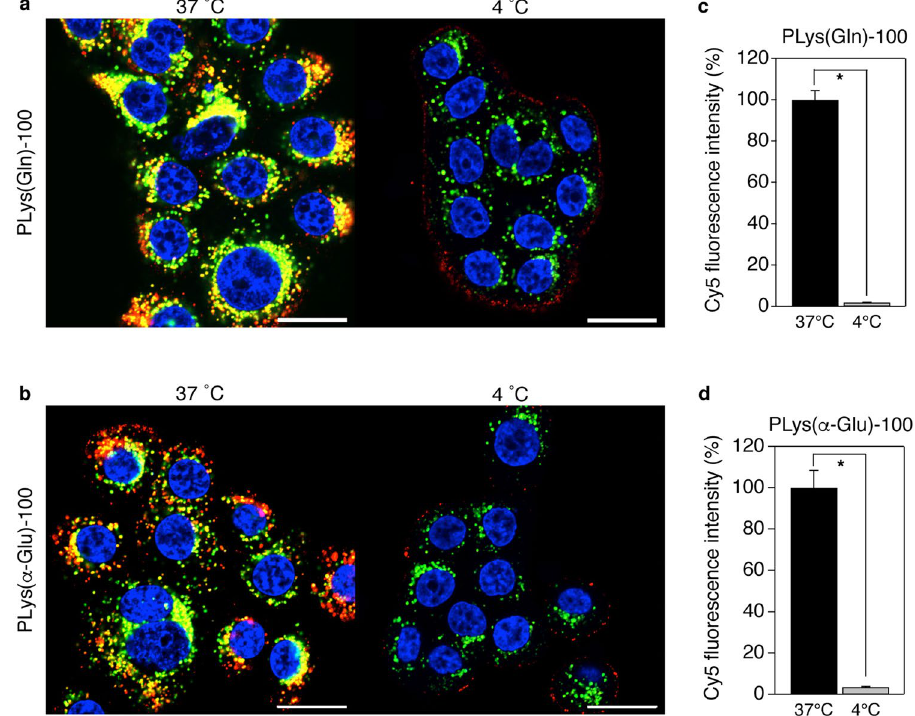
Figure 5. Subcellular distribution of PLys(Gln)-100 and PLys( α -Glu)-100. ( a , b ) Confocal laser scanning microscopic images of BxPC3 cells after 3 h treatment with PLys(Gln)-100 ( a ) and PLys( α -Glu)-100 ( b ) at 37 °C (left) and 4 °C (right). Red, Cy5-labeled polymers; green, late endosome/lysosome; blue, nucleus. Scale bar, 20 μ m. ( c , d ) Cy5 fluorescence intensities of BxPC3 cells after 3 h treatment with PLys(Gln)-100 ( c ) and PLys( α - Glu)-100 ( d ) at 37 °C and 4 °C. The cells were analysed using flow cytometer. Data are mean ± S.D. (n = 3). p * < 0.001 (Student’s t